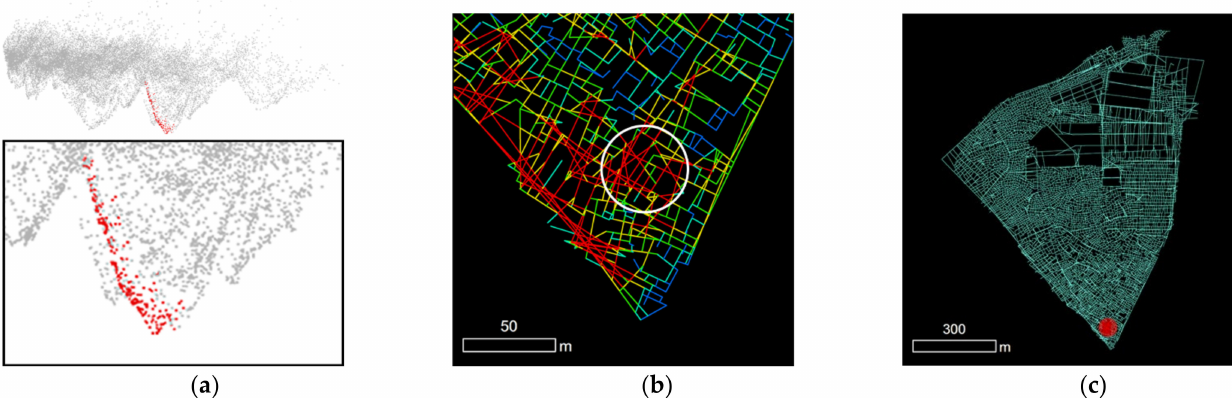
Figure 6. Background patchwork analysis (BPA) of BaSECo: (a) zoomed view of BPA at 100 m (Figure 5): red dots highlight the metric density of the space-in-between’s globular structure reported in sub-figures (b) zoomed view of local integration index with topological radius three steps (Figure 4b), and ( c ) location of the analyzed area on the urban